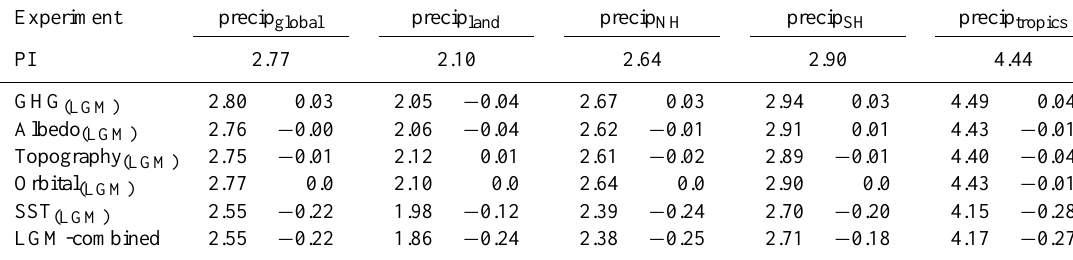
Table 4. As Table 3, but for precipitation in mmday − 1 .